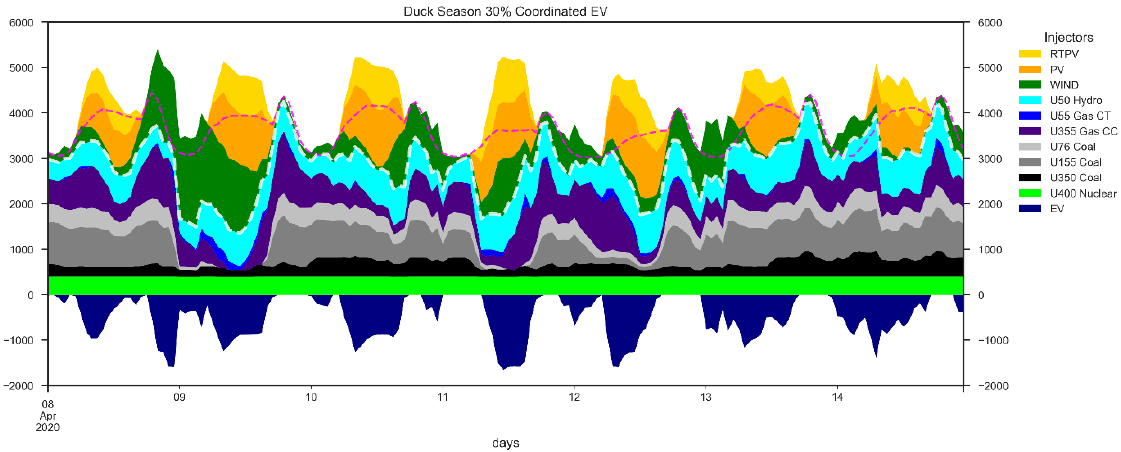
Figure 13. The generation stack for Duck week in April, assuming 30% EV penetration and coordi- nated EV charging.